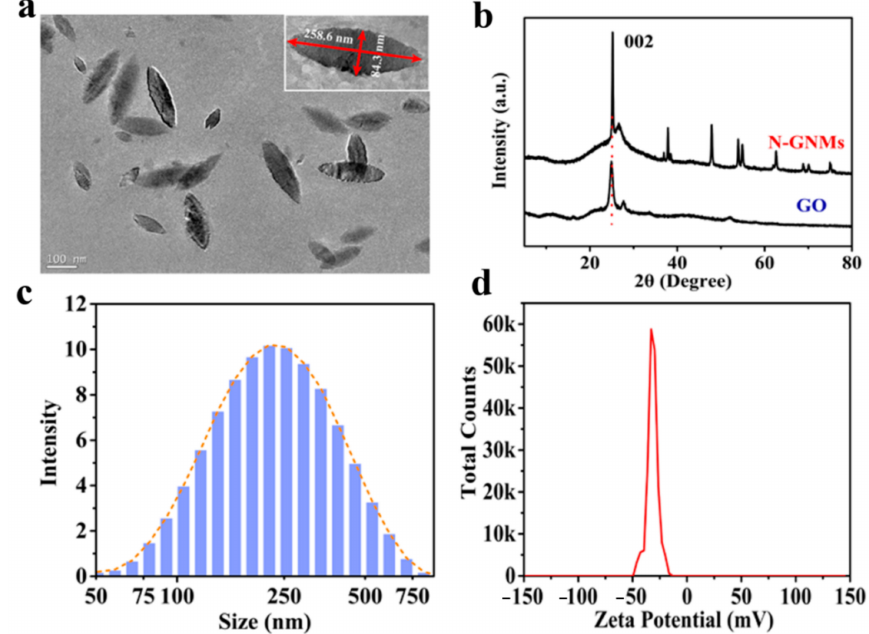
Figure 2. ( a ) TEM images of the N-GNMs; ( b ) XRD patterns of the N-GNMs and GO; ( c ) Particle size distribution and ( d ) Surface potential ( ζ ) analysis of the N-GNMs.